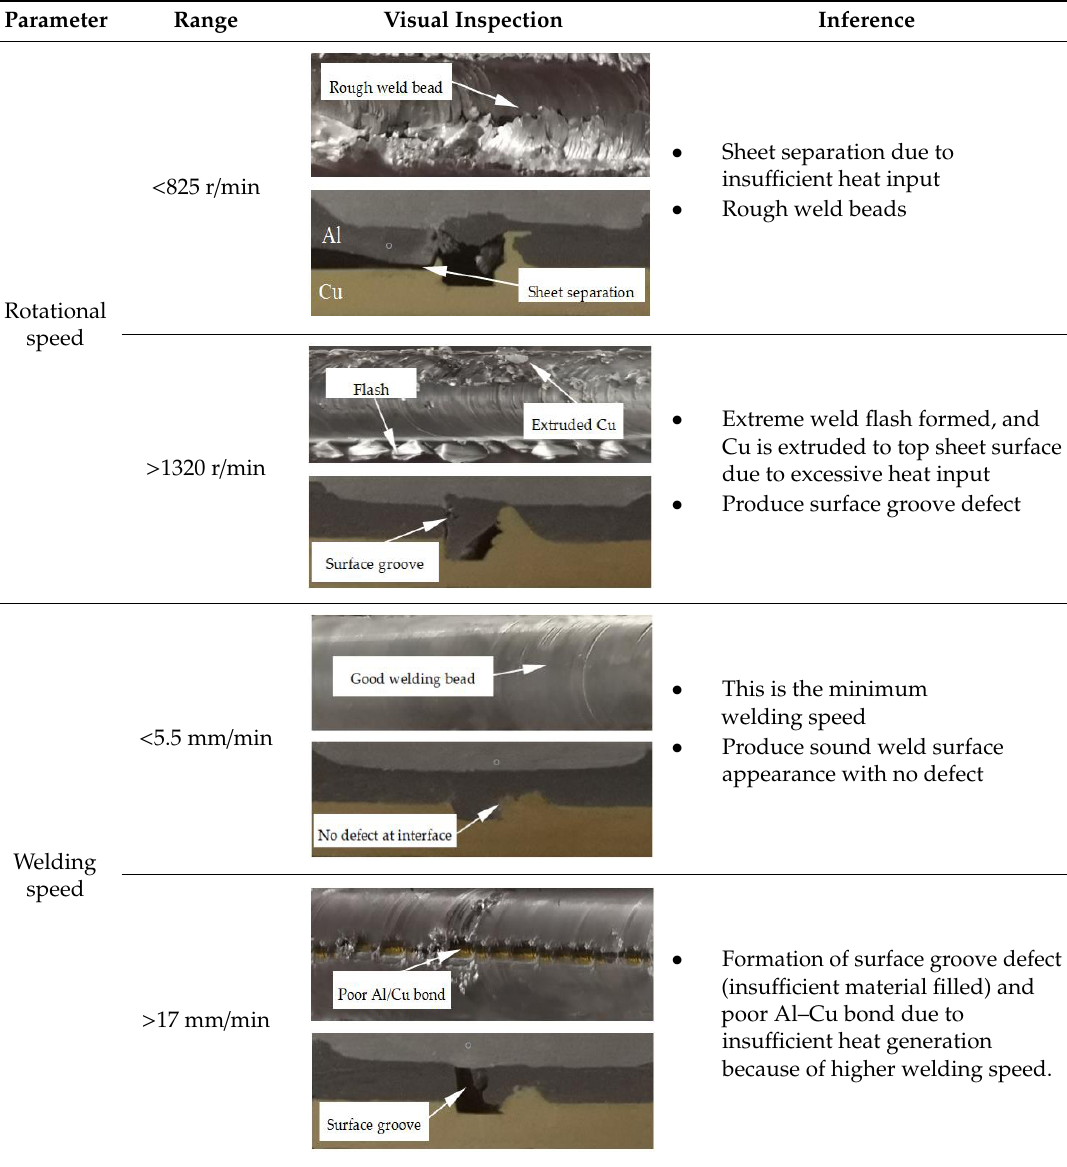
Table 2. Inferences from feasible operating limits of welding parameters.